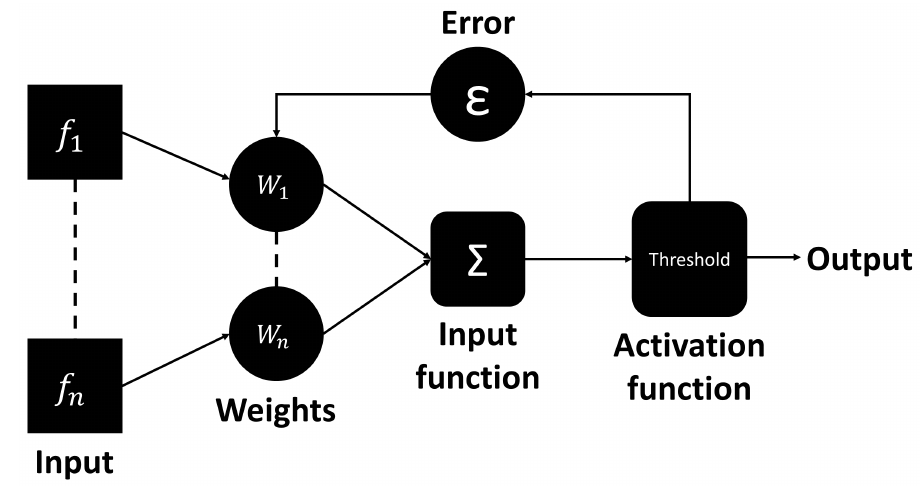
Figure 1. The perceptron rule. Graphical representation of the process of weight adjustment and the operation chain from the input to the